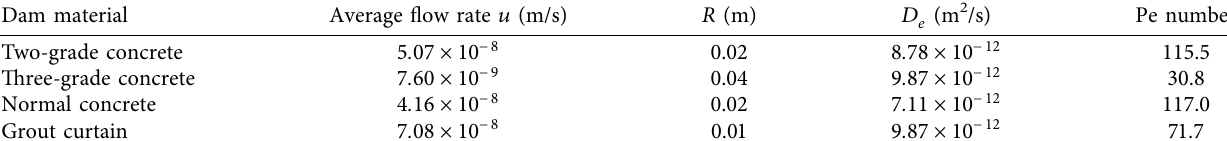
Table 4: Pe numbers of different dam materials at initial condition.